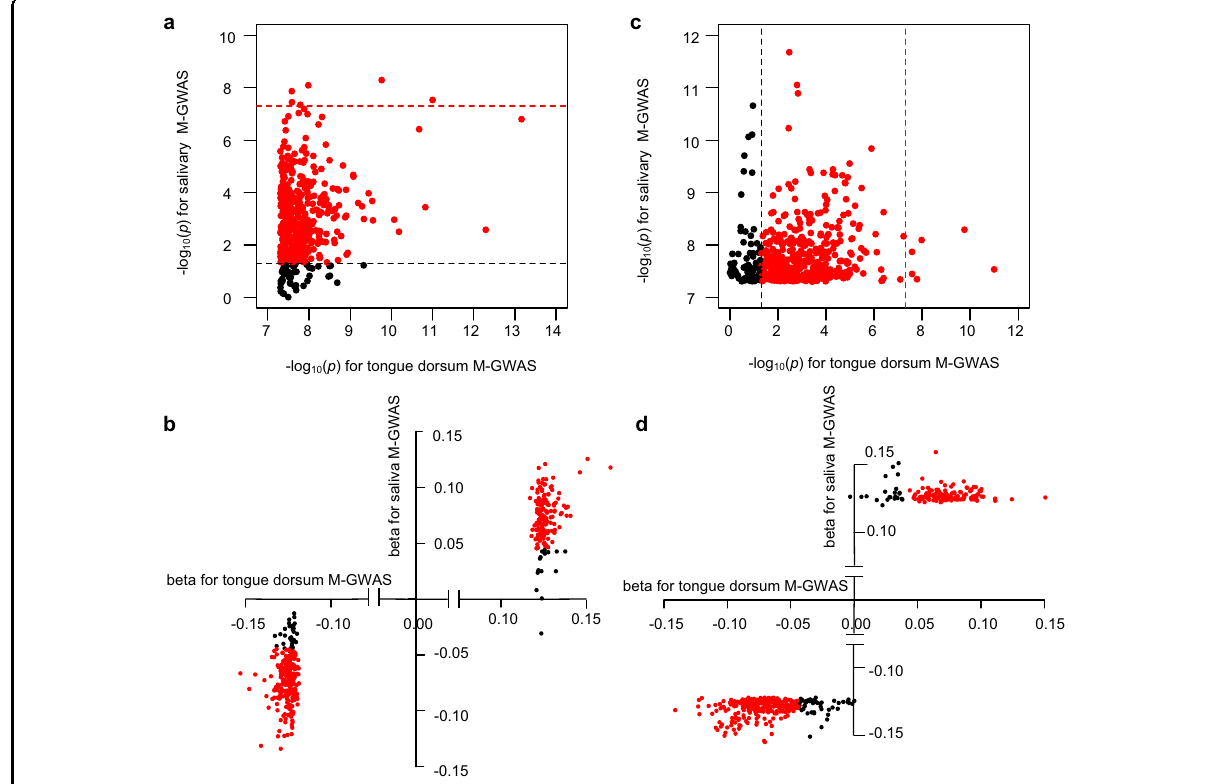
Fig. 5 Comparisons of mgGWAS associations between tongue dorsum and saliva samples. a p -values comparisons of the 345 and 374 independent loci associated with tongue dorsum and salivary microbiome ( p < 5 × 10 − 8 ), respectively. b β -values comparisons of the 345 and 374 independent loci associated with tongue dorsum and salivary microbiome ( p < 5 × 10 − 8 ) , respectively. In a and b , the six genome-wide signi fi cant loci shared by tongue dorsum and salivary microbiome were listed. The dots marked red and black represented shared associations by both ( p < 5 × 10 − 8 in one niche and p < 0.05 in the other niche in the same direction of the minor allele) and speci fi c associations ( p < 5 × 10 − 8 in one niche but p > 0.05 in the other niche or the opposite direction of the minor allele) in one niche,